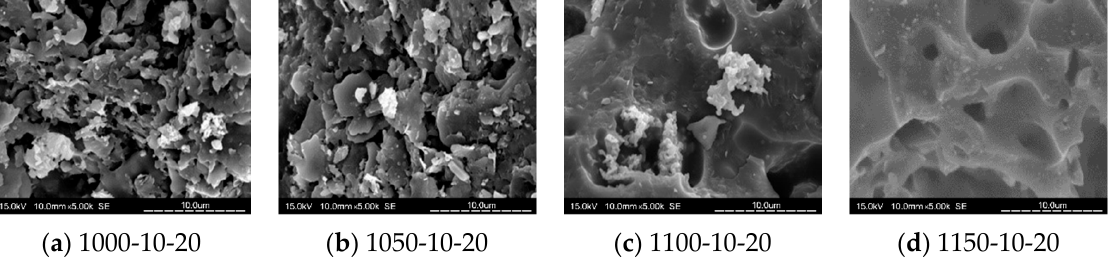
Figure 12. SEM of 20% SSA replacement and various MIBA at 1100 °C. ( a ) 1100 °C ‐ 20% SSA ‐ 5% MIBA; ( b ) 1100 °C ‐ 20% SSA ‐ 10% MIBA ; ( c ) 1100 °C ‐ 20% SSA ‐ 15% MIBA ; ( d ) 1100 °C ‐ 20% SSA ‐ 20% MIBA.